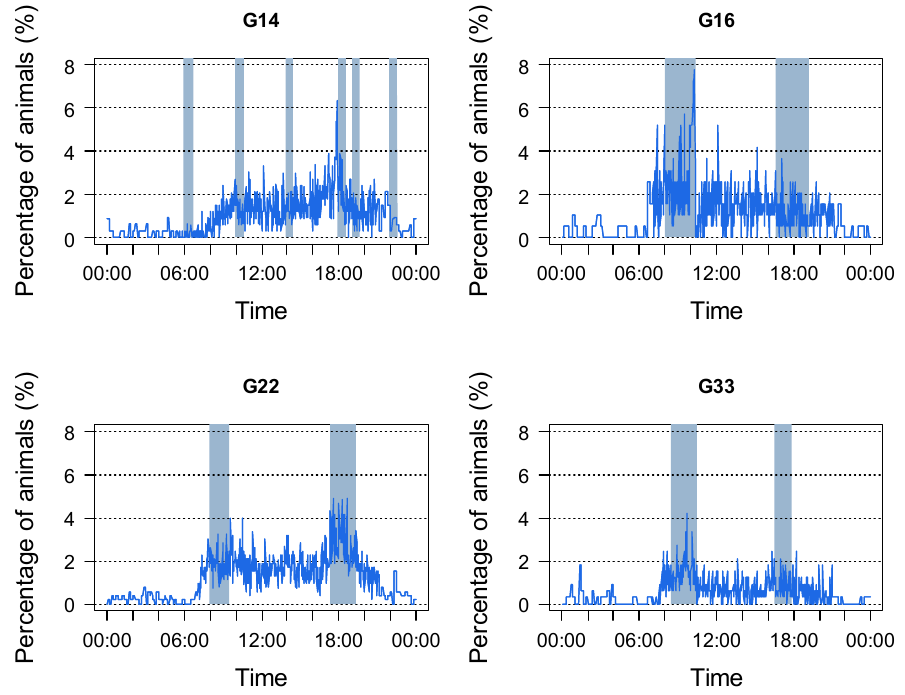
Figure 3. Averaged percentage of animals per pen performing stereotypies over a 24 h period. G14 = groups of 14 animals, G16 = groups of 16 animals, G22 = groups of 22 animals, G33 = groups of 33 animals. Blue areas = periods of feed delivery. Data were averaged for each interval for three observation periods of two days each and two groups of G16 and G33 as well as four groups of G14 and G22 each.